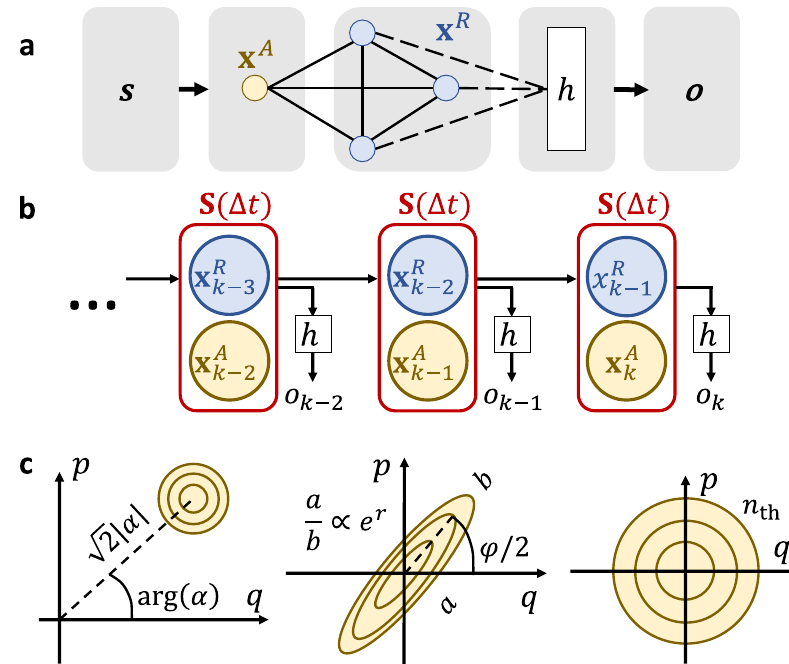
Fig. 1 Reservoir computing scheme. a The overall input-output map. The input sequence s is mapped to a sequence of ancillary single-mode Gaussian states. These states are injected one by one into a suitable fi xed quantum harmonic oscillator network by sequentially resetting the state of the oscillator chosen as the ancilla, x A . The rest of the network — taken to be the reservoir — has operators x R . Network dynamics maps the ancillary states into reservoir states, which are mapped to elements of the output sequence o by a trained function h of reservoir observables. Only the readout is trained whereas the interactions between the network oscillators remains fi xed, which is indicated by dashed and solid lines, respectively. b The corresponding circuit. The reservoir interacts with each ancillary state through a symplectic matrix S ( Δ t ) induced by the network Hamiltonian H during constant interaction time Δ t . Output ( o k ) at timestep k is extracted before each new input. x A k are the ancillary operators conditioned on input s k and x R k are the reservoir operators after processing this input. c Wigner quasiprobability distribution of ancilla encoding states in phase space of ancilla position and momentum operators q and p . Here, the contours of the distribution are indicated by dark yellow lines. Input may be encoded in coherent states using amplitude ∣ α ∣ and phase arg ð α Þ of displacement α 2 C , or in squeezed states using squeezing parameter r and phase of squeezing φ (where a and b are the length and height of an arbitrary contour), or in thermal states using thermal excitations n th